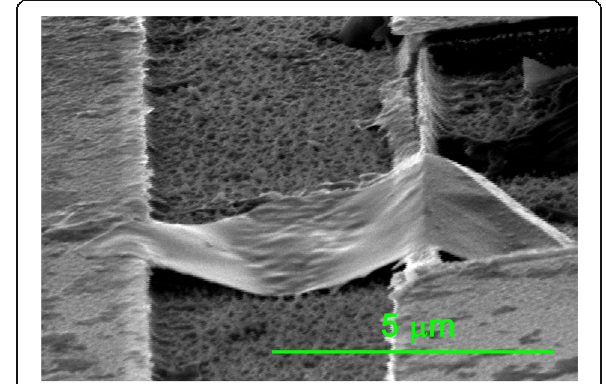
Fig. 4 SEM image of the ReSe 2 flake and the Au nanofilm in slant view of